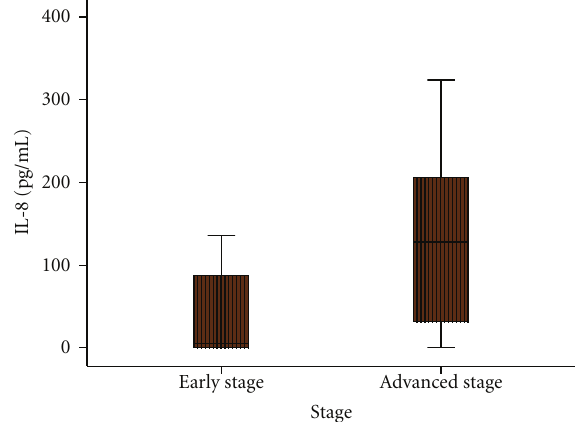
Figure 3: Association between serum IL-8 levels and histopatho- logical stage of thyroid carcinoma patients.